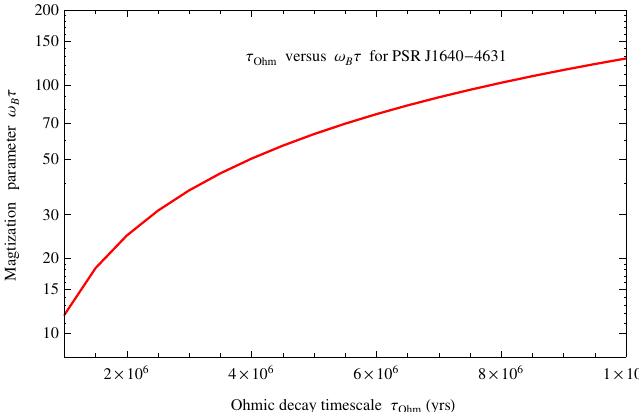
Figure 2. The relation of τ Ohm and ω B τ for PSR J1640-4631.